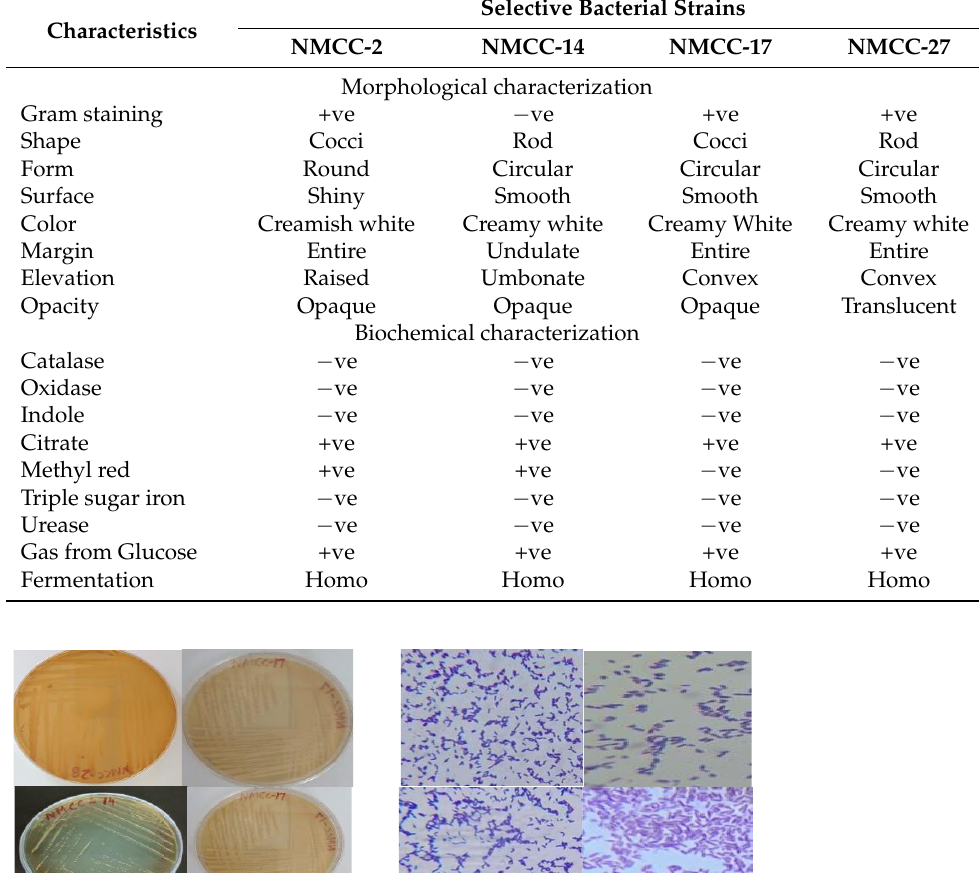
Table 2. Morphological and biochemical characterization of bacterial isolates on MRS agar.